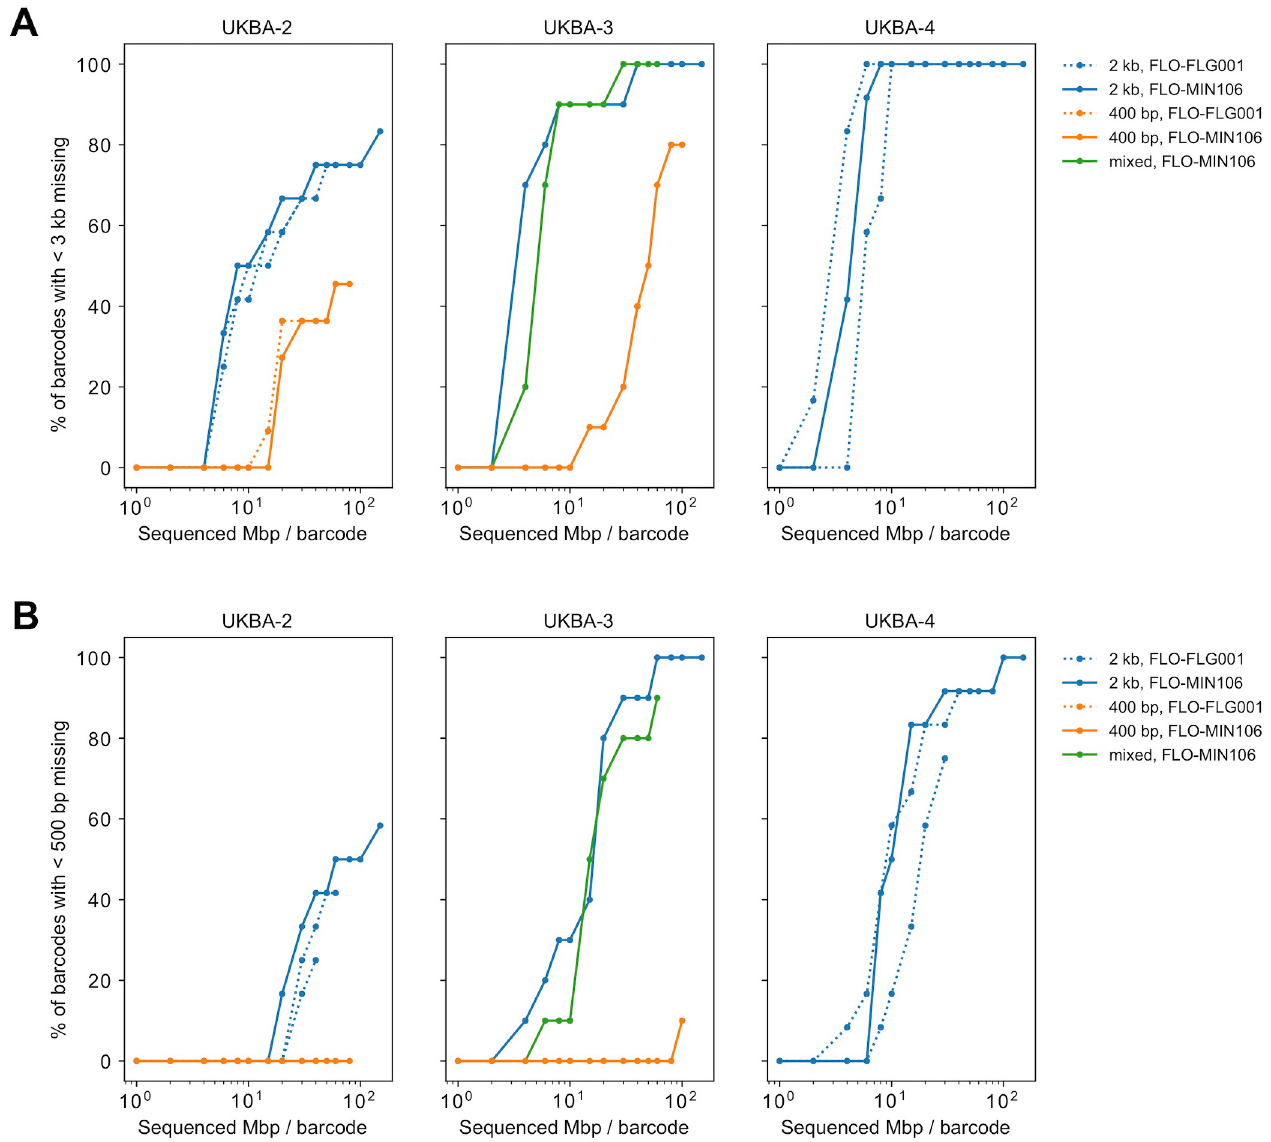
Fig 1. The percentage of successfully sequenced multiplexed samples over time. A sample is considered as successfully sequenced if the resulting sequence produced by the Artic pipeline has fewer than 500-bp (A) or 3-kb (B) marked as missing bases. Each run is represented by several time points, each point showing the percentage of successfully sequenced barcodes (y-axis) upon reaching a specified amount of sequenced data per barcode (x-axis).